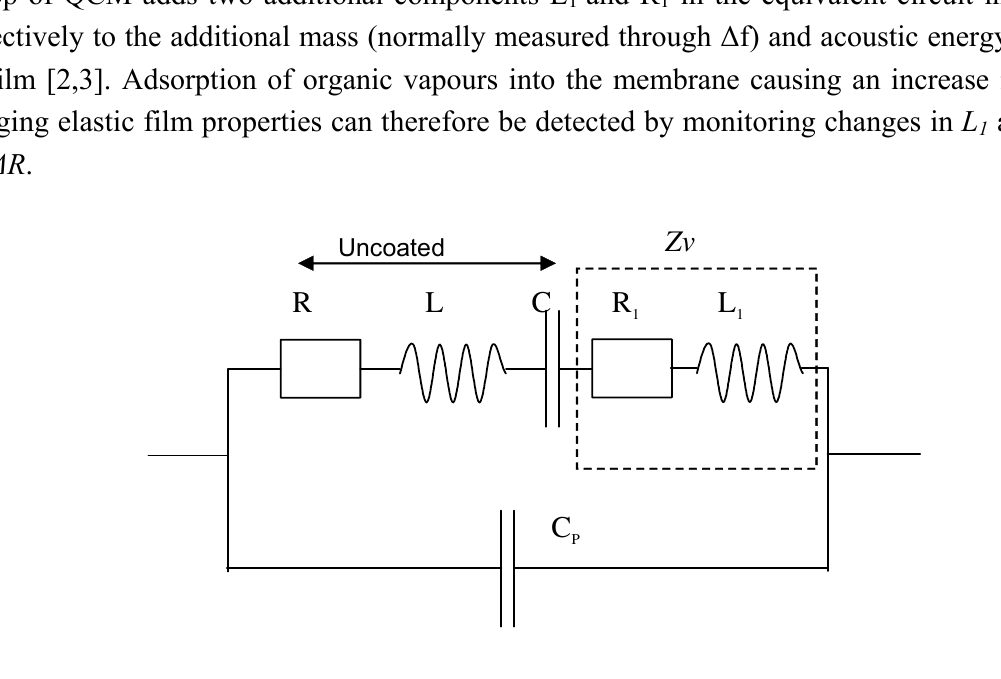
Figure 1. Butterworth Van Dyke (BVD) equivalent circuit model of TSM resonator near resonance.